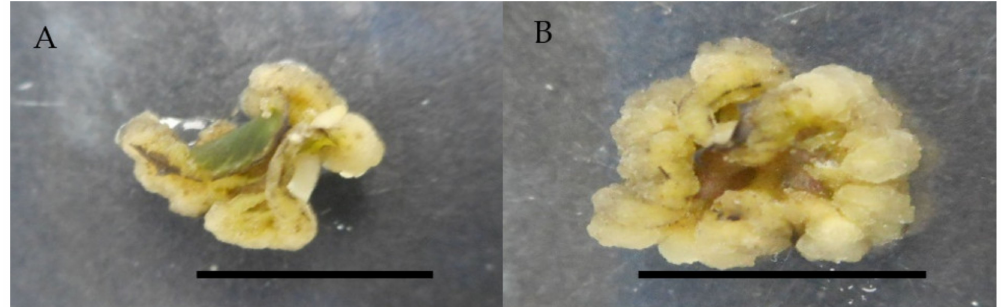
Figure 3. Callus induction of Labisia pumila var. alata on MS medium with combination of 2,4-D and cytokinins after 4 weeks of culture. ( A ) 0.5 mg/L 2,4-D + 0.25 mg/L zeatin and ( B ) 0.5 mg/L 2,4-D + 0.25 mg/L kinetin. Horizontal bar = 1 cm.